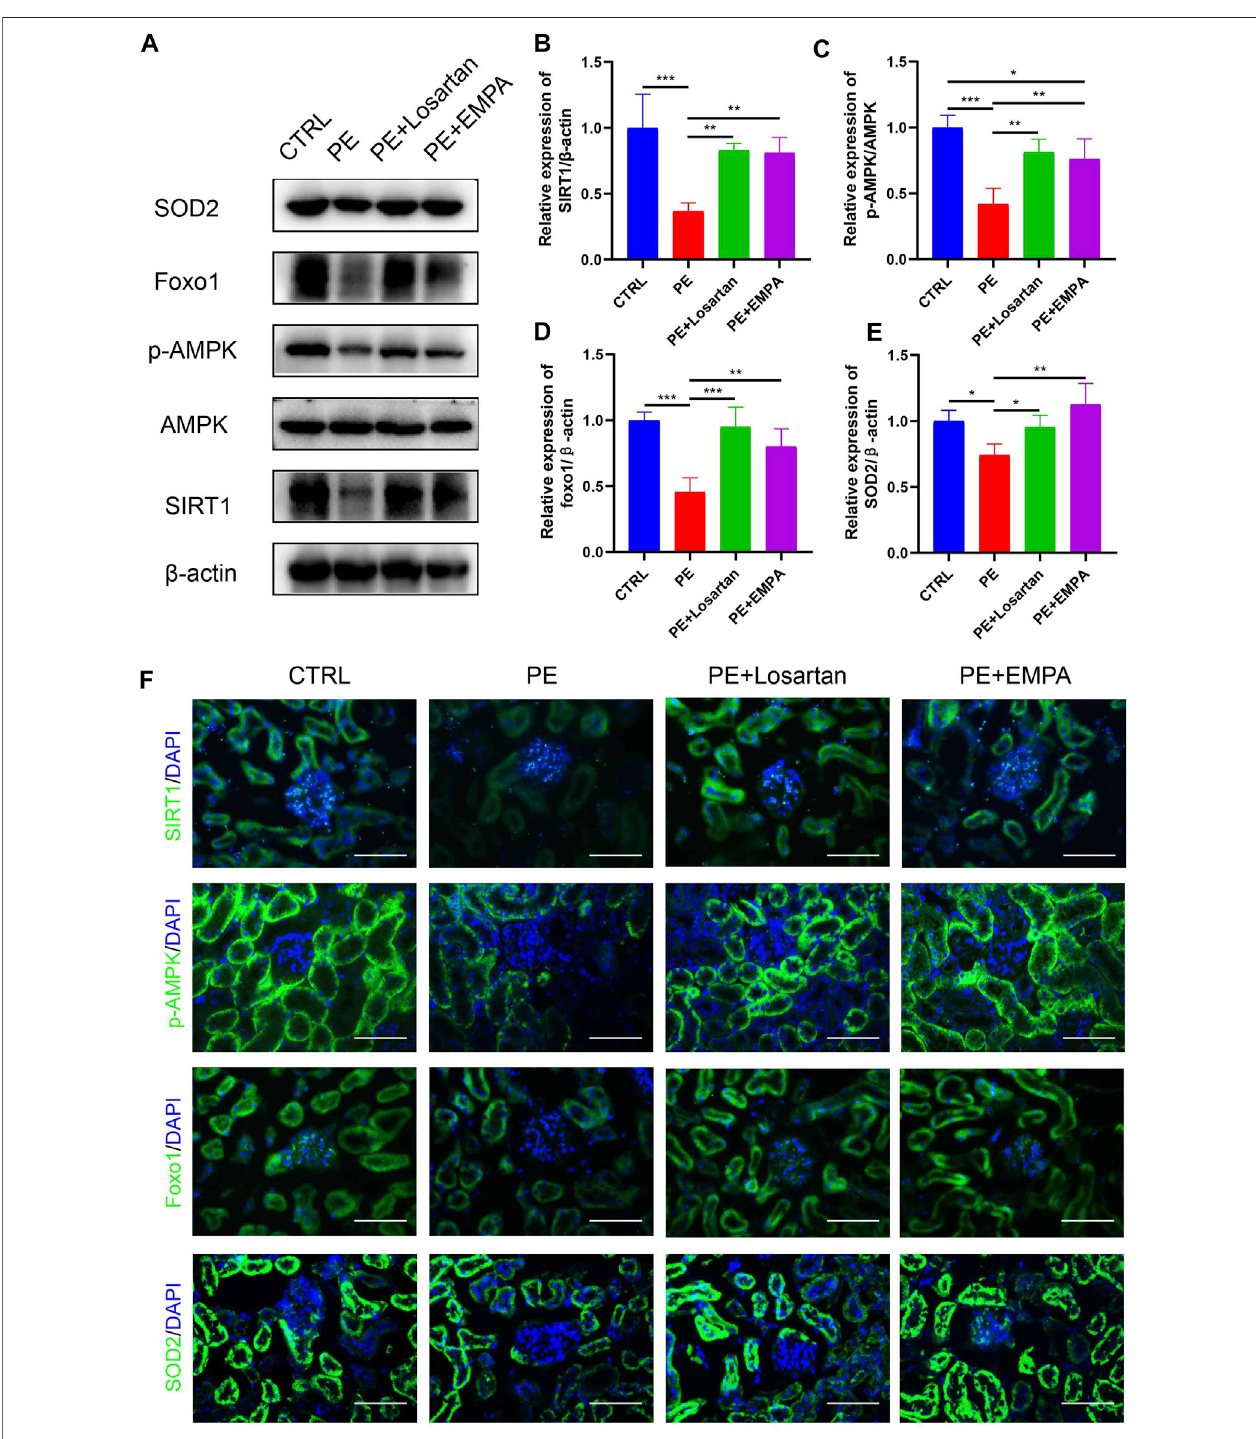
FIGURE 5 | Effects of EMPA on the AMPK/SIRT1 pathway and oxidative stress in AT1-AA-induced PE mouse kidneys. (A) Protein levels of SIRT1, AMPK, p-AMPK, Foxo1 and SOD2 in the kidney determined by Western blot analysis. (B) Densitometric evaluation of Western blots for SIRT1 ( n = 3), (C) p-AMPK ( n = 3), (D) Foxo1 ( n = 3) and (E) SOD2 ( n = 3). (F) Representative immuno fl uorescence images of SIRT1, p-AMPK, Foxo1 and SOD2 in kidneys of different groups. Scale bar: 50 μ m. Data are expressed as the mean ± SEM and were analyzed by ANOVA with LSD post hoc test. * p < 0.05, ** p < 0.01, *** p < 0.001.